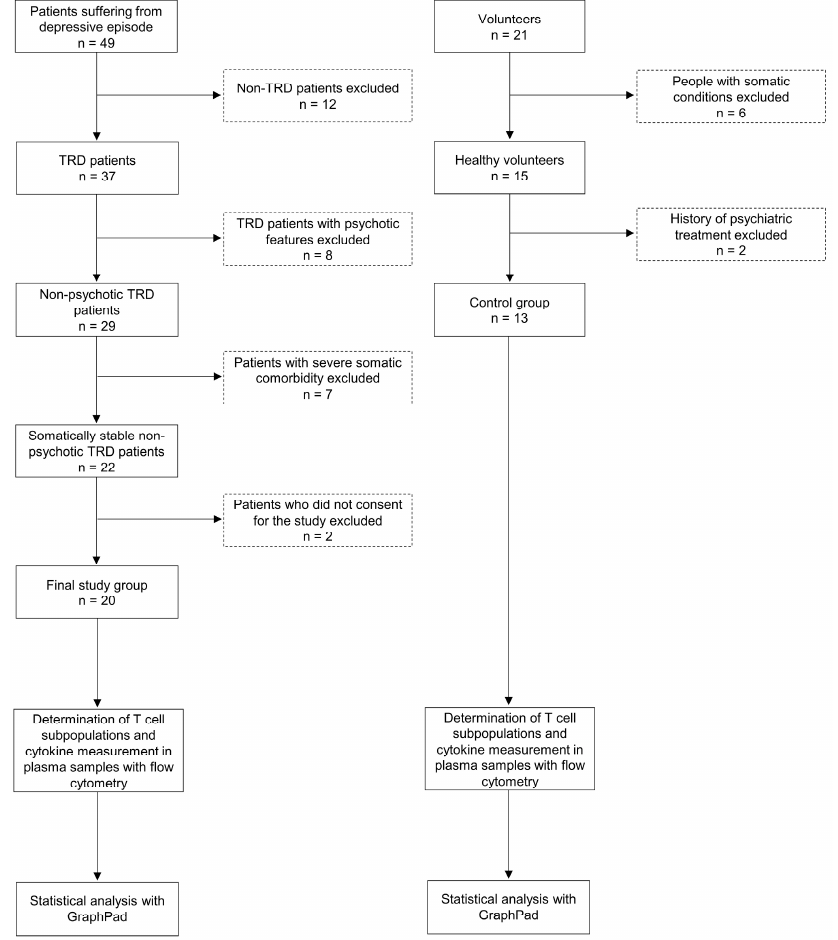
Figure 5. Flow chart of the study